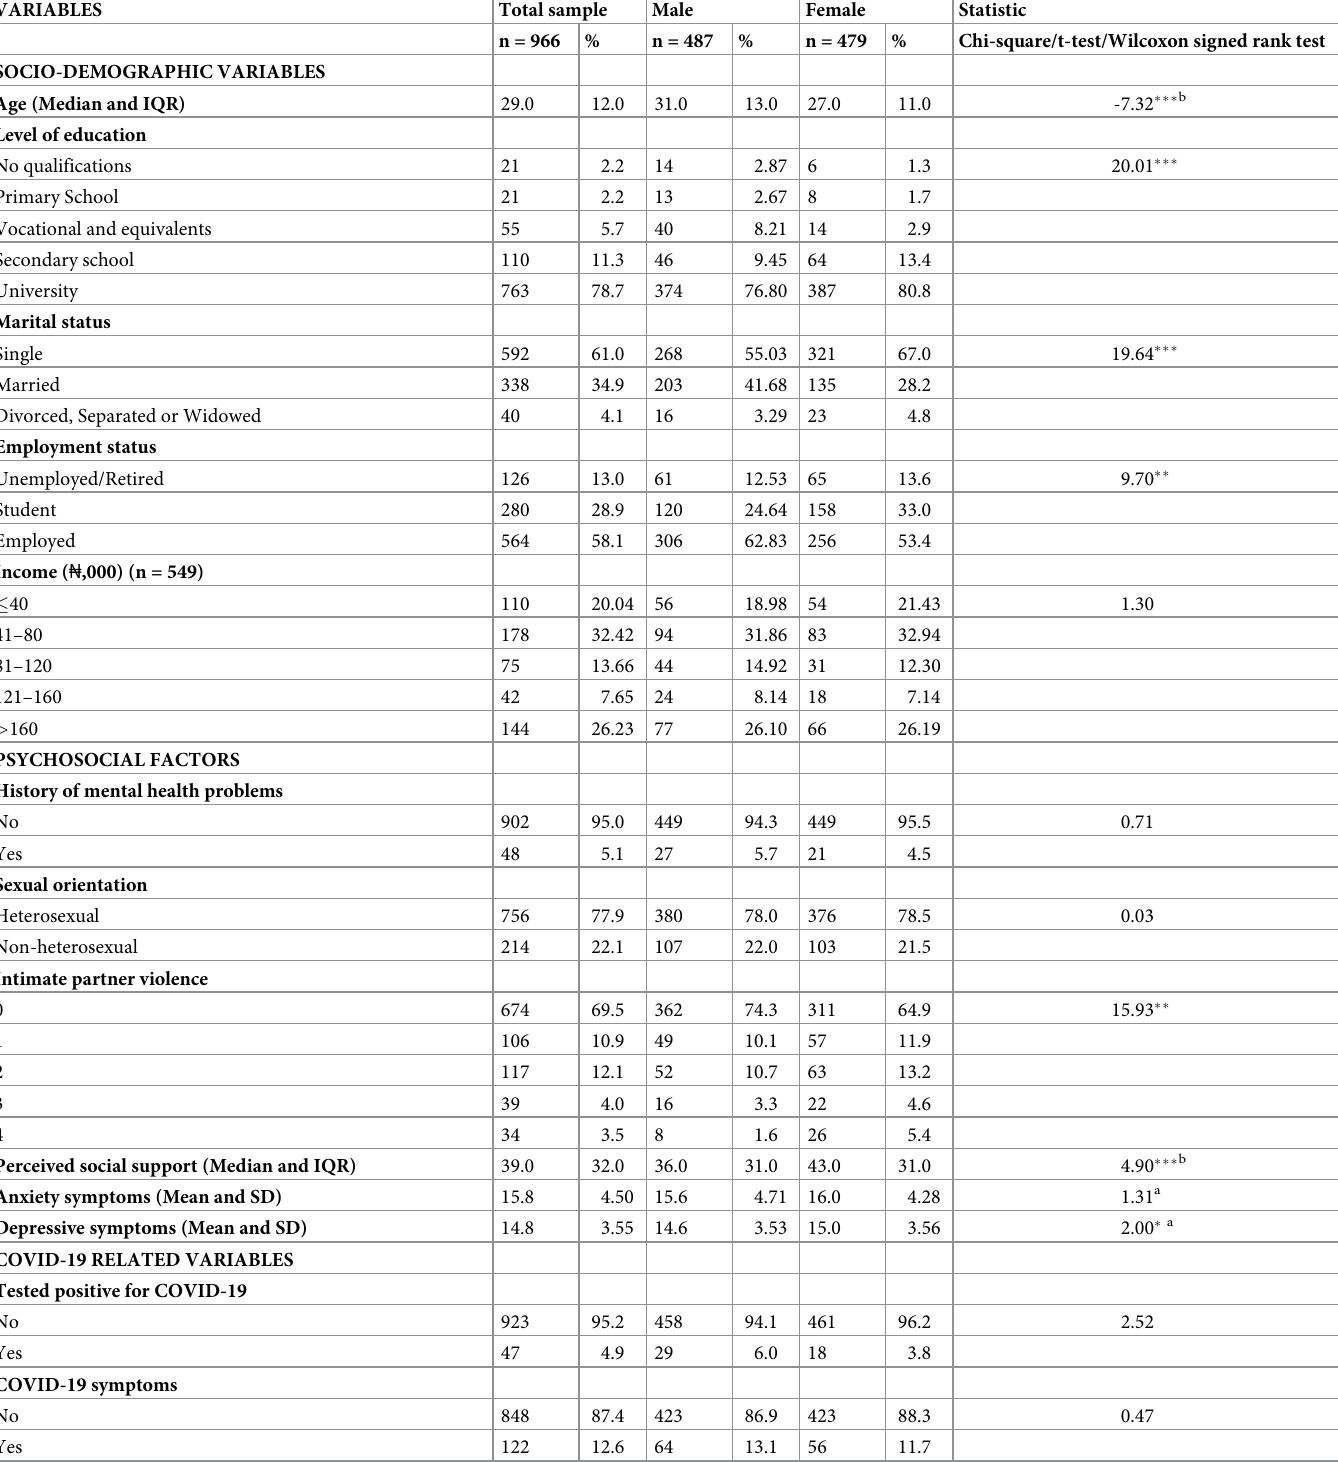
Table 1. Sociodemographic, COVID-19-related and psychosocial factors with sex differences.